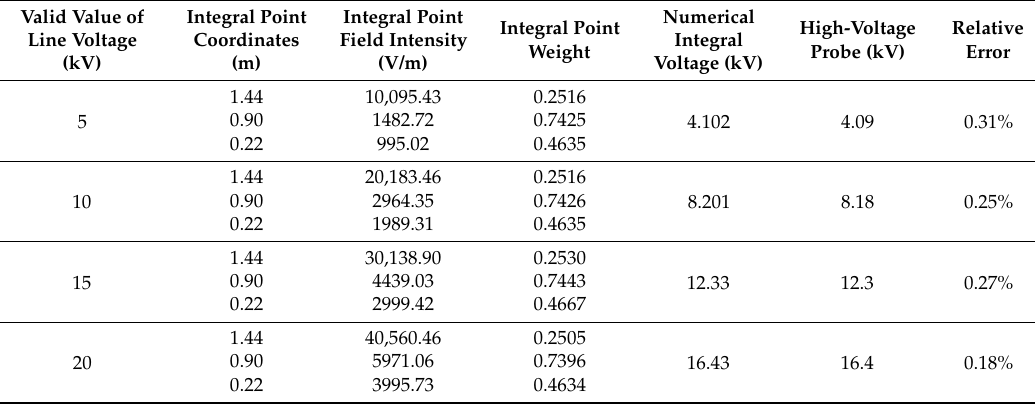
Table 4. The results of the Gaussian integral from the experiment.